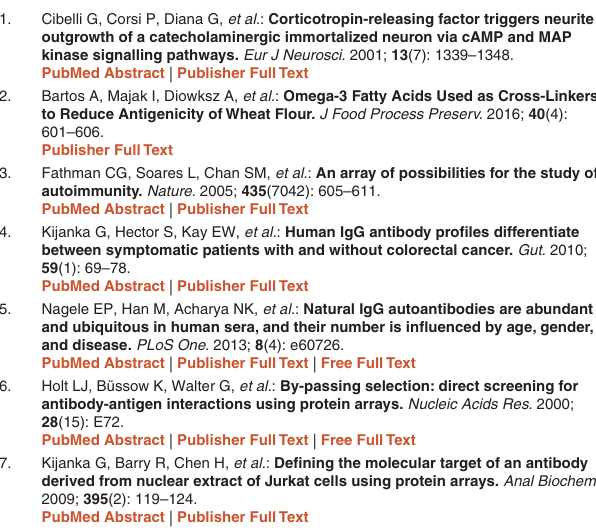
Supplementary Table S1. Chicken IgY, rabbit IgG and array-identified human proteins in silico sequence analysis data. In order to investigate whether potential shared epitopes exist between immunogens (chicken IgY, rabbit IgG) used to produce the secondary antibodies tested in this study and the human proteins bound non-specifically by those secondary antibodies on protein arrays, we analysed sequence similarities using BLASTP and the local similarity program SIM. We used sequences of protein IDs provided by the Unipex protein database and compared those to chicken and rabbit immunoglobulin proteins (Methods section, Epitope analysis). The Table S1 shows the results for all possible two-pair sequence alignment combinations presented as BLAST scores, E-values and SIM scores. Figure S1. Unipex 1 pt.1 protein array image. Original image of protein array (Number 633.4.730) probed with rabbit anti-chicken IgY and alkaline phosphatase-conjugated goat anti-rabbit IgG, visualised using AttoPhos AP Fluorescent Substrate. Figure S2. Unipex 2 pt.1 protein array image. Original image of protein array (Number 634.5.737) probed with rabbit anti-chicken IgY and alkaline phosphatase-conjugated goat anti-rabbit IgG, visualised using AttoPhos AP Fluorescent Substrate. Figure S3. Unipex 1 pt.1 protein array image with highlighted positive signals. Cross-reactive proteins listed in Table 4 are highlighted corresponding to their intensity as red (intensity 3 = strong), green (intensity 2 = intermediate) and yellow (intensity 1 = weak) circles. Figure S4. Unipex 2 pt.1 protein array image with highlighted positive signals. Cross-reactive proteins listed in Table 4 are highlighted corresponding to their intensity as red (intensity 3 = strong), green (intensity 2 = intermediate) and yellow (intensity 1 = weak)